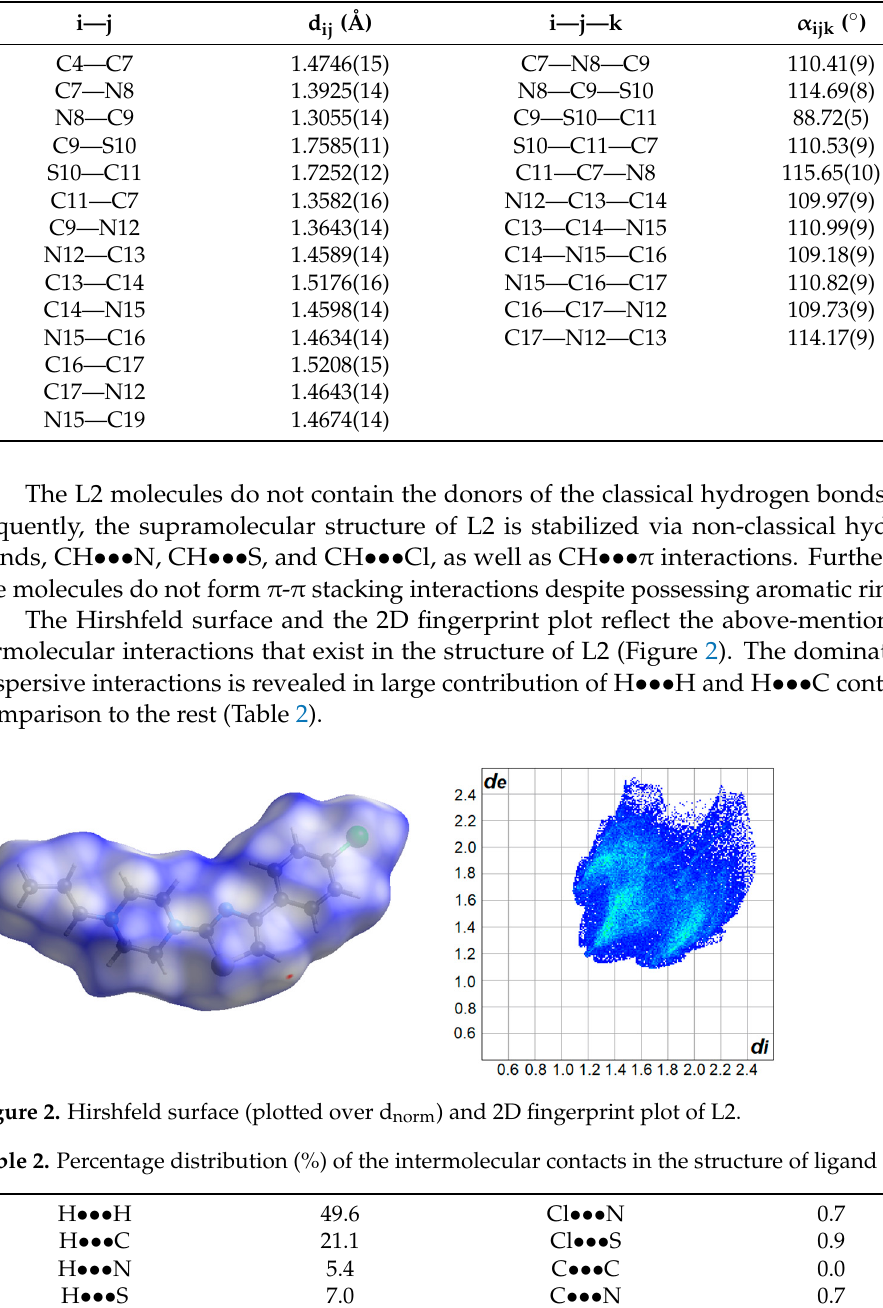
Table 1. Selected structural data of ligand L2.